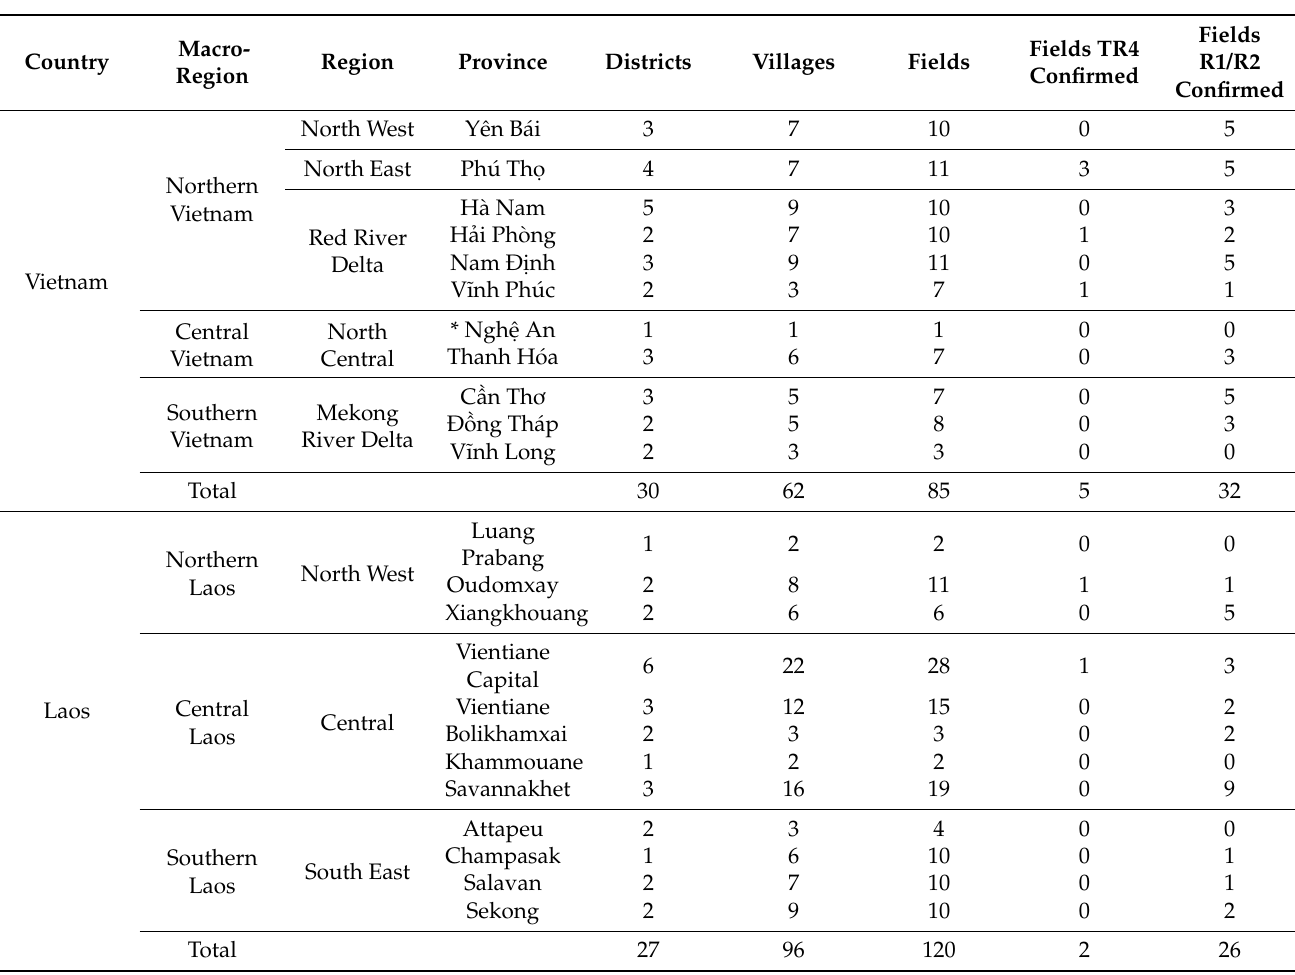
Table 2. Survey overview of the 2020 survey. The number of districts, villages and fields are indicated for each province surveyed. The number of fields in which Fusarium oxysporum f. sp. cubense (Foc) TR4 and Foc R1/R2 were positively identified are indicated. Foc TR4 and Foc R1/R2 were